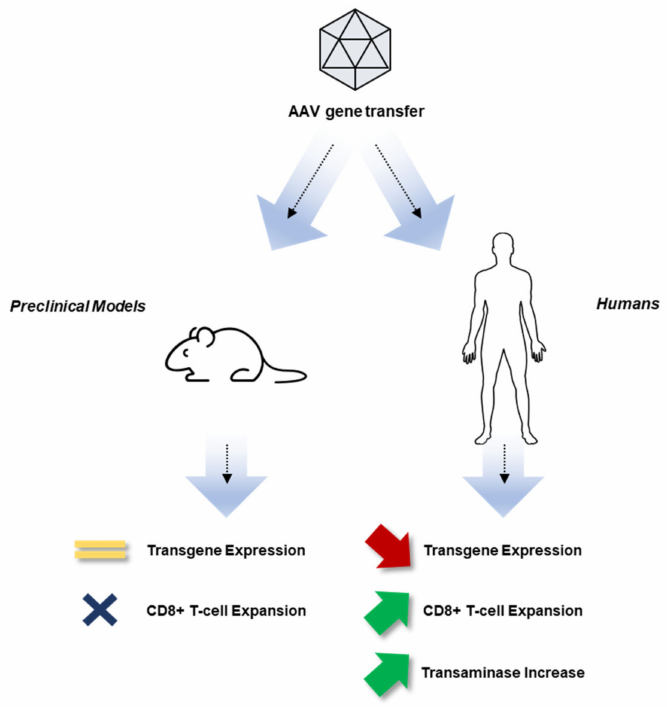
Figure 1. Immune response to AAV gene transfer. In the first gene transfer clinical trial hepatic gene transfer for hemophilia B, an AAV2 vector expressing the human FIX transgene was administered via the hepatic artery. Results in mice and other preclinical animal models showed persistence of transgene expressing and no immune responses following AAV gene transfer. In humans, transgene expression was initially detected but started to decline after 4 to 6 weeks concomitant to an increase in liver enzymes and the detection of T-cell reactivity against the vector capsid. Subsequent studies [16] showed that cytotoxic T-lymphocyte (CTL) expansion detected in the peripheral blood was triggered by the administration of the AAV2 vector in humans and was likely responsible for the clearance of AAV-transduced hepatocytes. As noted, CD8+ T-lymphocyte expansion was not observed in preclinical animal models, in which stable transgene expression had been observed [16]. AAV, adeno-associated virus; FIX, factor